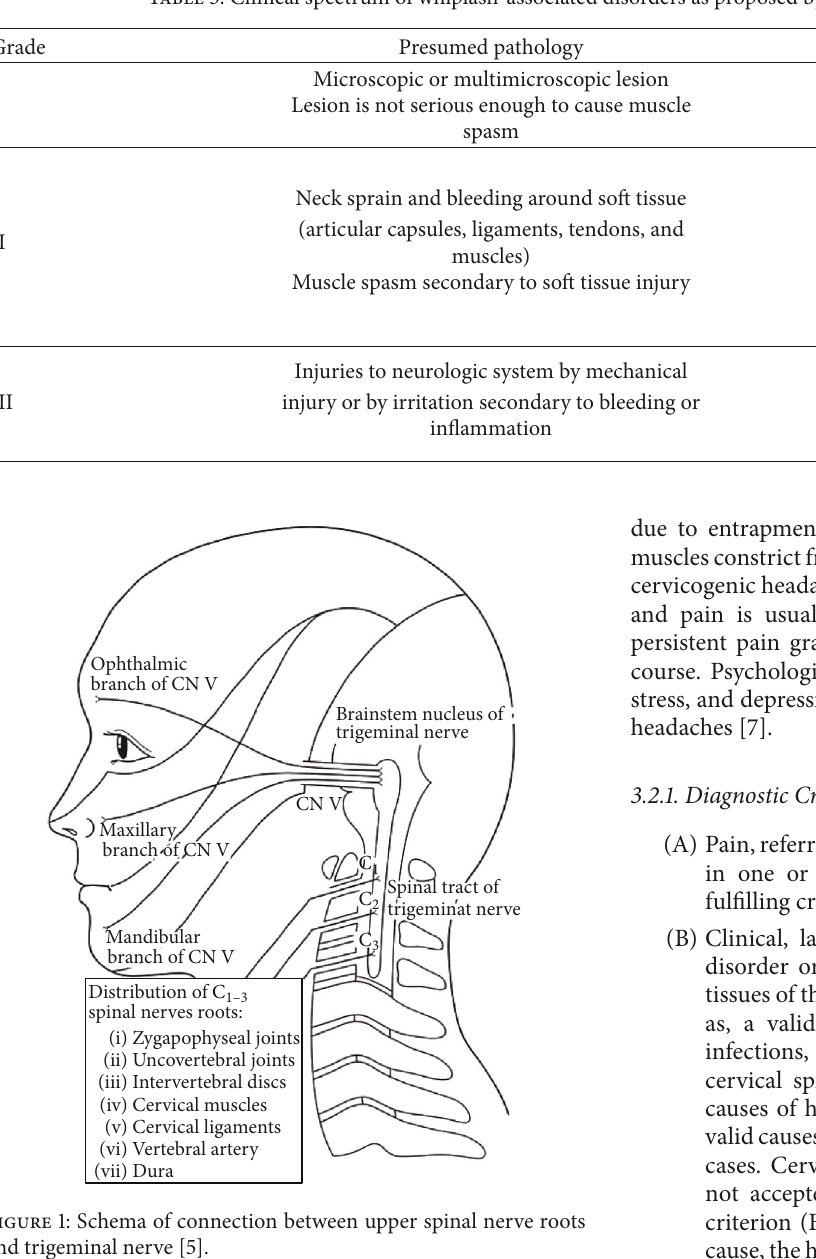
Table 3: Clinical spectrum of whiplash-associated disorders as proposed by the Quebec Task Force [2].